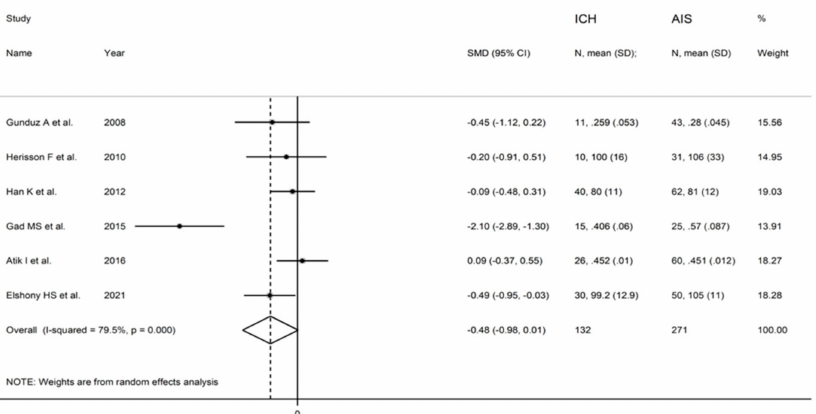
Figure 10. Forest plot of studies examining ischaemia-modified albumin in patients with intracerebral haemorrhage and acute ischaemic